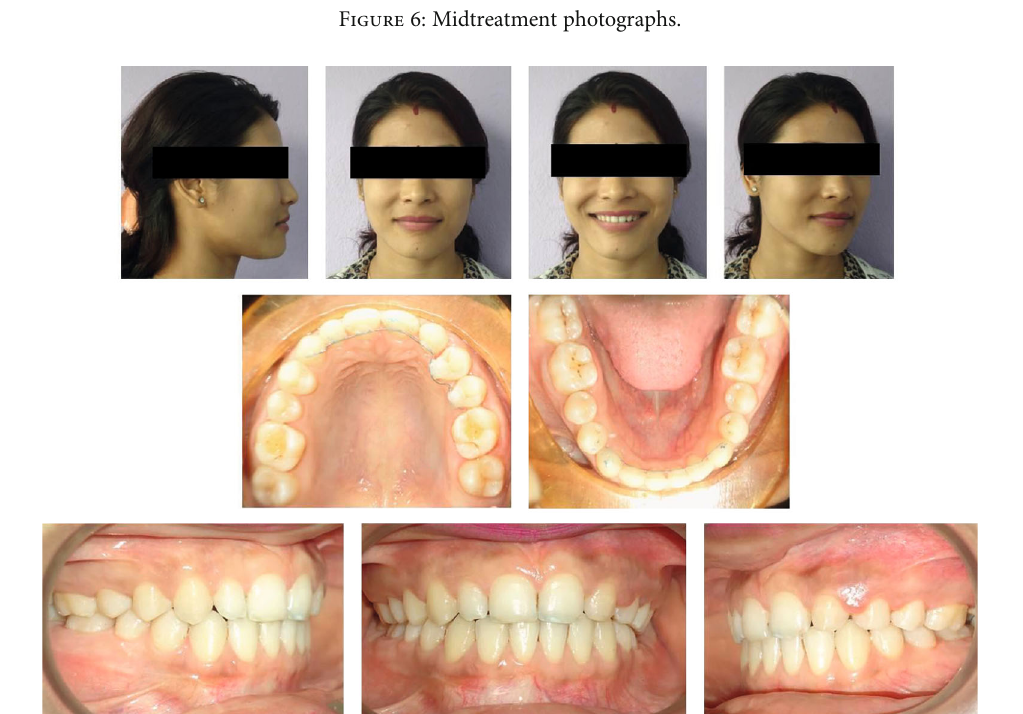
Figure 7: Posttreatment extraoral and intraoral